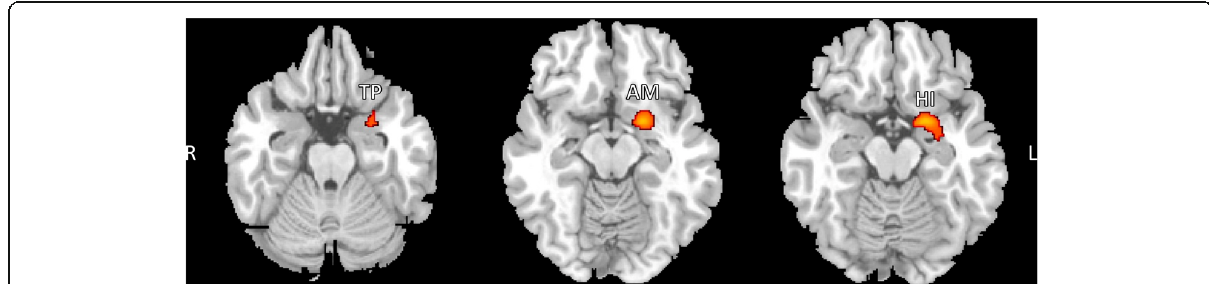
Fig. 1 SPM regions superimposed on a high-resolution T1-weighted scan show decreased GM volume in patients with CM compared to HCs ( p <0.001 uncorrected). Areas with significantly reduced GM volume are observed in the left amygdala (AM), left temporal pole (TP), and left hippocampus (HI). L=left, R=right